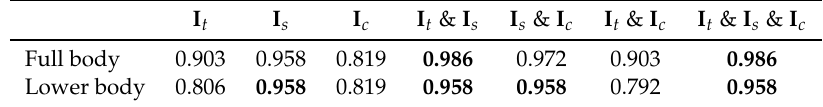
Table 4. The AUCs estimated from each single gait index and possible combinations. The notations are similar to Equation (8) and the best results corresponding to each row are highlighted in